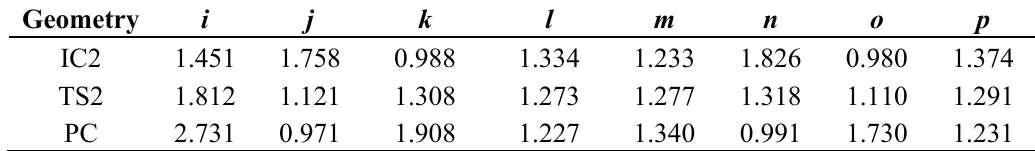
Figure 5. The geometry of IC1 (the intermediate complex directly connected to TS1). Selected interatomic distances are shown in Å. Table 2. Changes of the interatomic distances i – p (see Figure 6) (Å) in the second step.